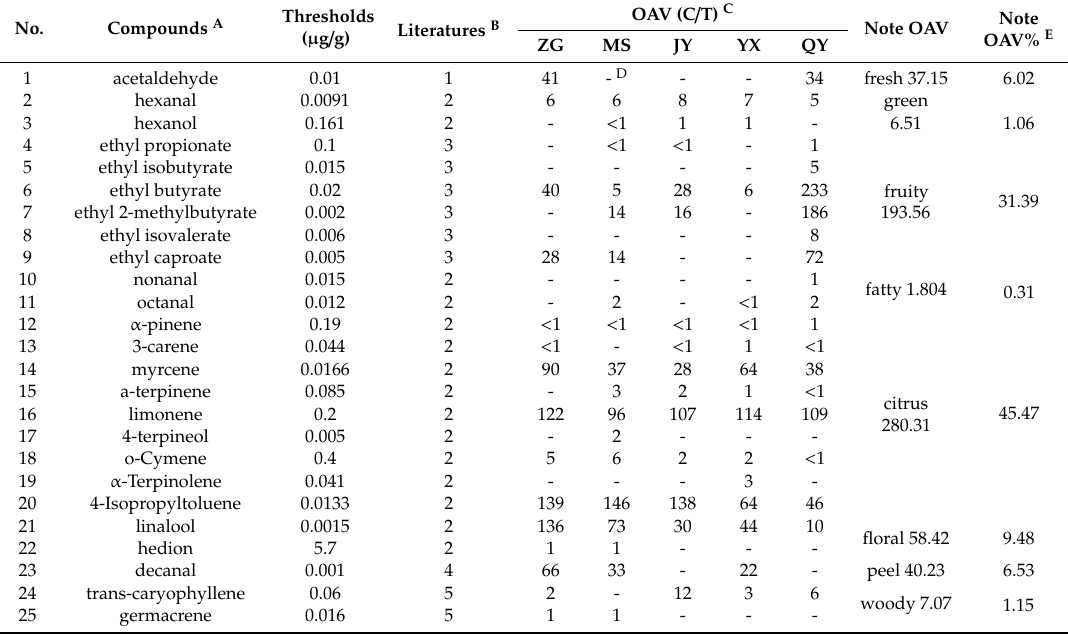
Table 3. Average OAV value and aroma note percentage of volatile compounds in sweet orange. No.